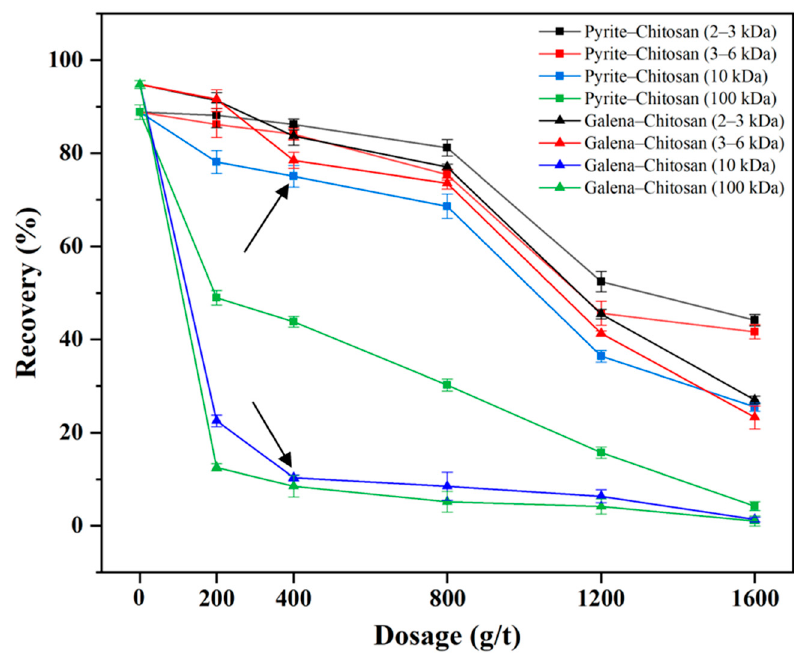
Figure 4. Pyrite and galena recovery results of single-mineral flotation experiments using chitosan with different dosages and molecular weights as a depressant, 1600 g/t ethyl xanthate as a collector, and 100 g/t terpineol as a frother at pH 8.